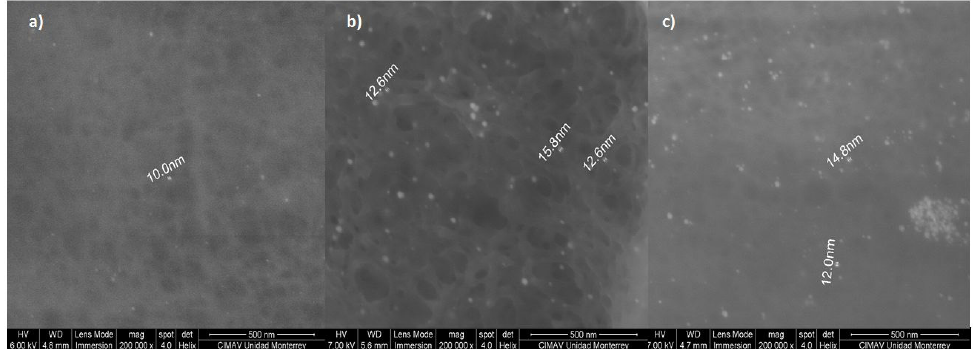
Figure 4. Scanning electron microscopy micrographs of CTS-g- GMA-Au-Col nanocomposites: ( a ) 0.3 mM, ( b ) 0.6 mM, ( c ) 1.07 mM. The increment of nanoparticles in the material induces the formation of clusters.